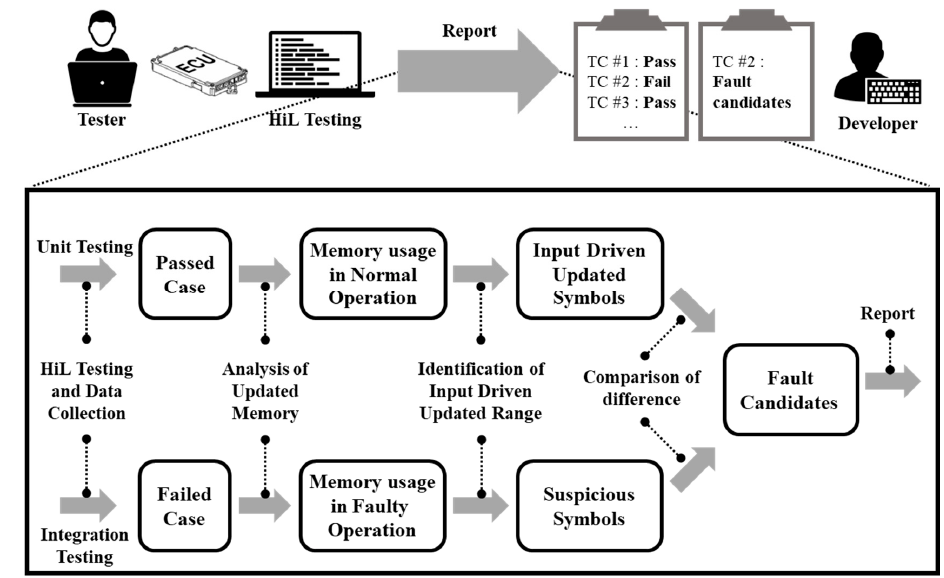
Figure 3. Process of fault localization through analysis of updated memory.